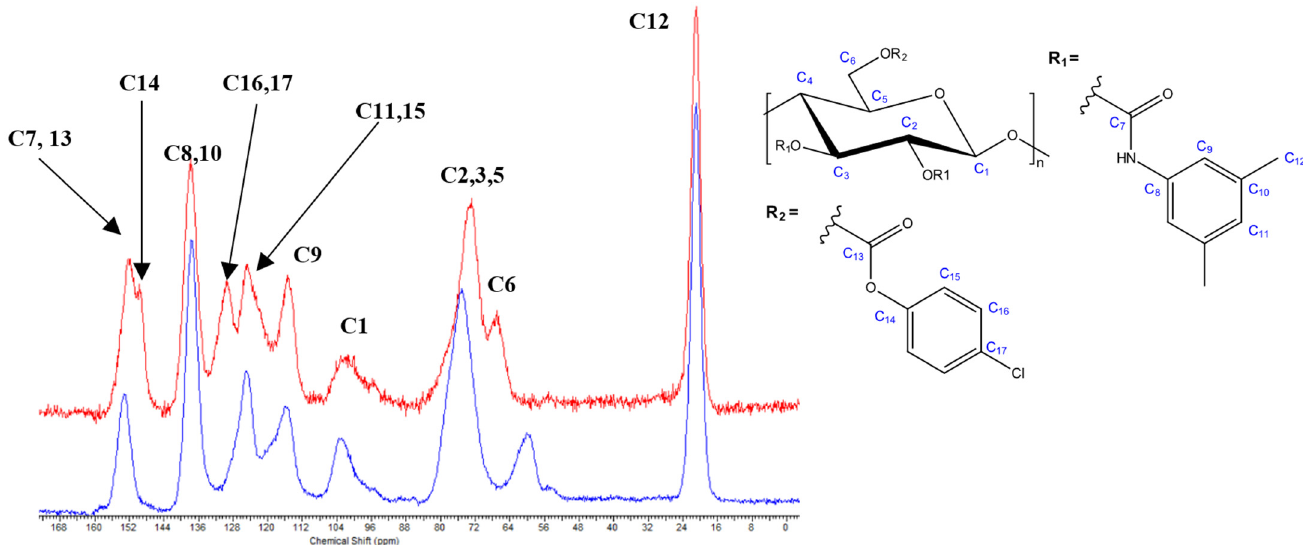
Figure 3. Solid-state 13 C NMR spectra of cellulose derivative 11b (red) vs. 10